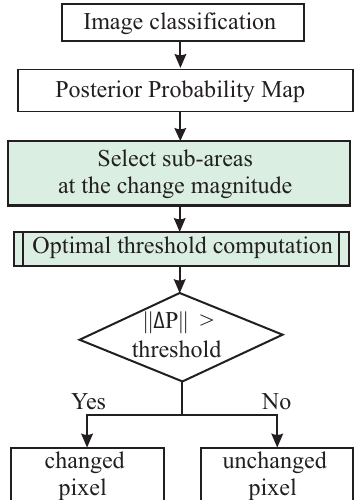
Figure 3: Flowchart of the CVA change detection.